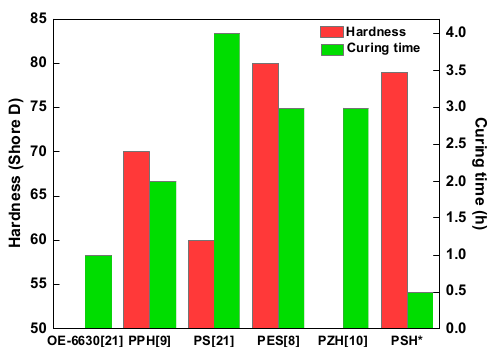
Figure 4. Hardness (Shore D) and curing times of OE-6630, polyphony hybrimer (PPH), PS, PES, PZH, and PSH. * indicates this work.